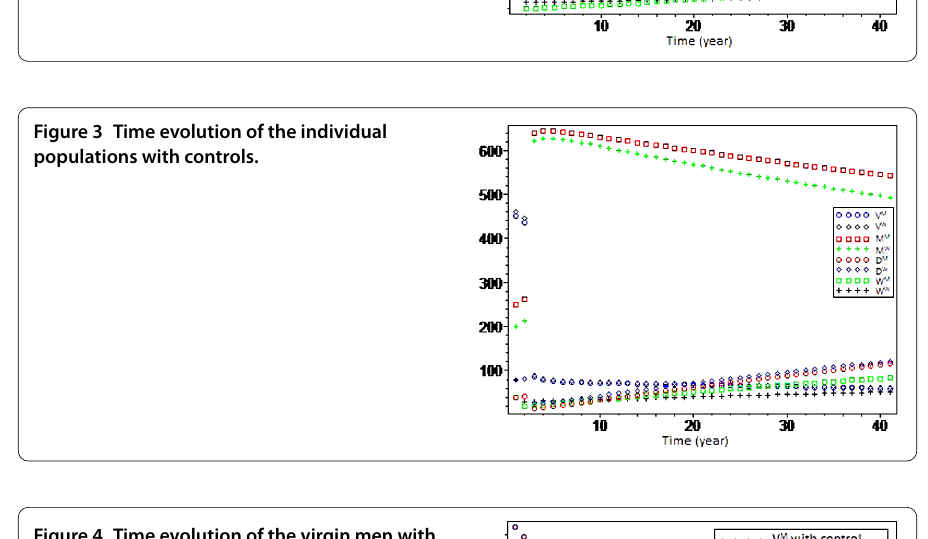
Figure 4 Time evolution of the virgin men with and without